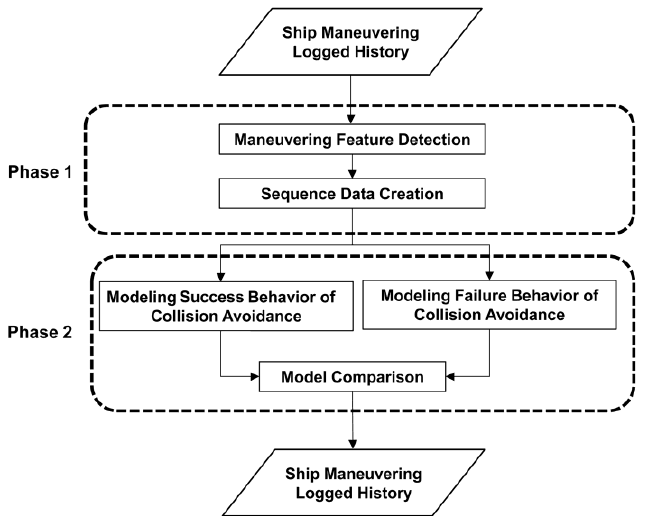
Figure 1. Research framework for the development of maneuvering behavior models for ship collision avoidance.